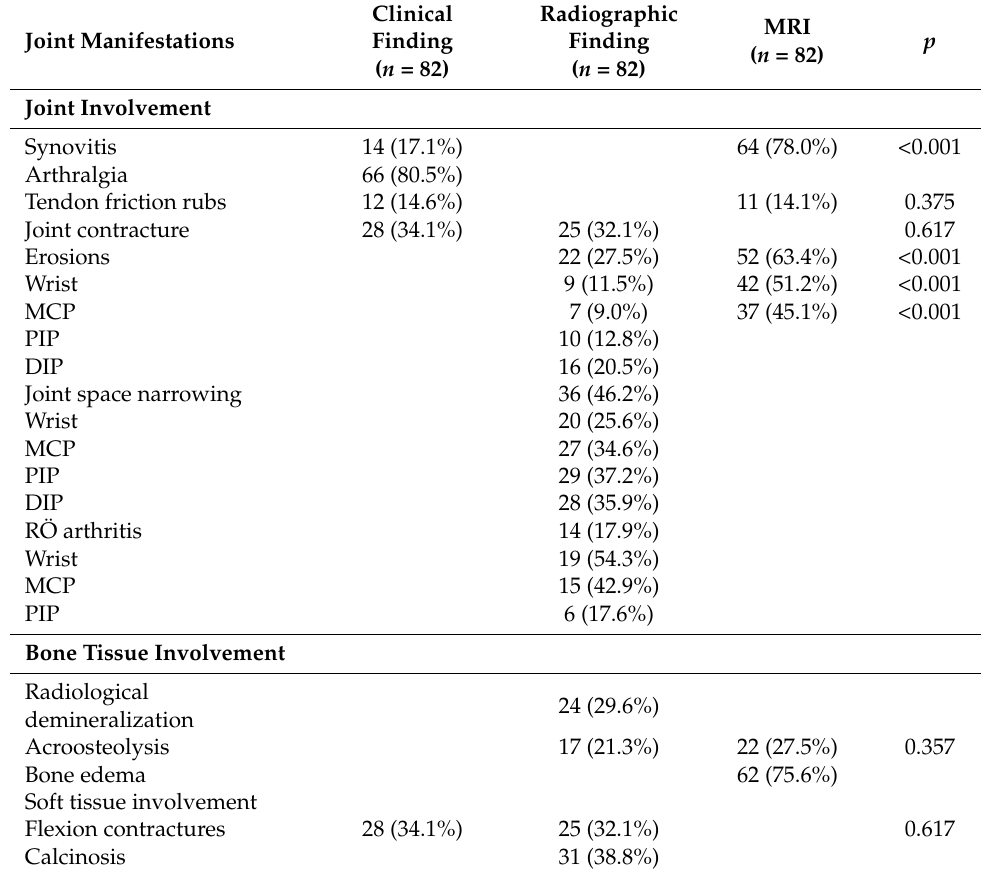
Table 3. Musculoskeletal manifestations in systemic sclerosis assessed by clinical findings, radio- graphic findings, and magnetic resonance imaging (MRI).